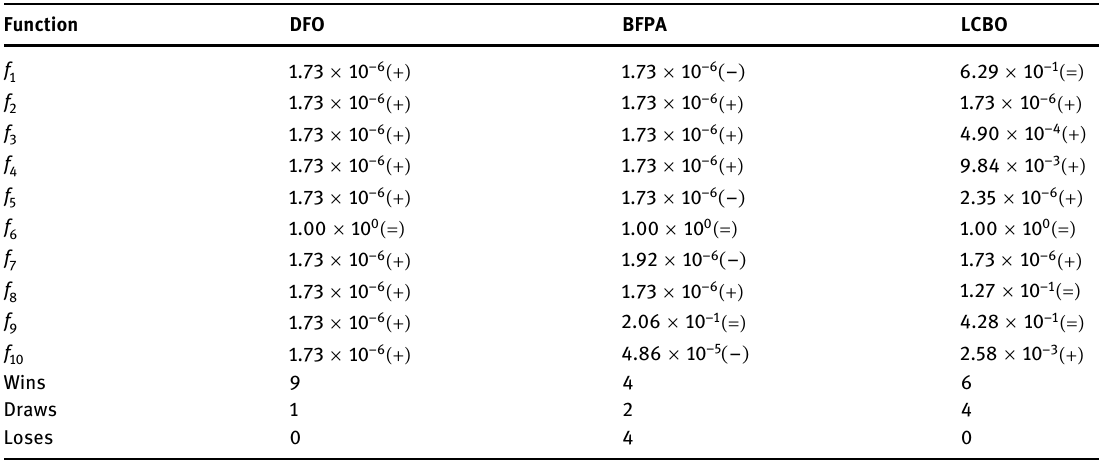
Table A4: The CEC 2020 ( = D 20 ) statistical analysis showing the Wilcoxon test p - value